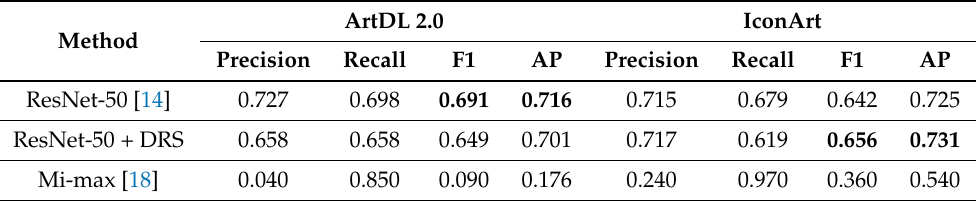
Recall Recall F1